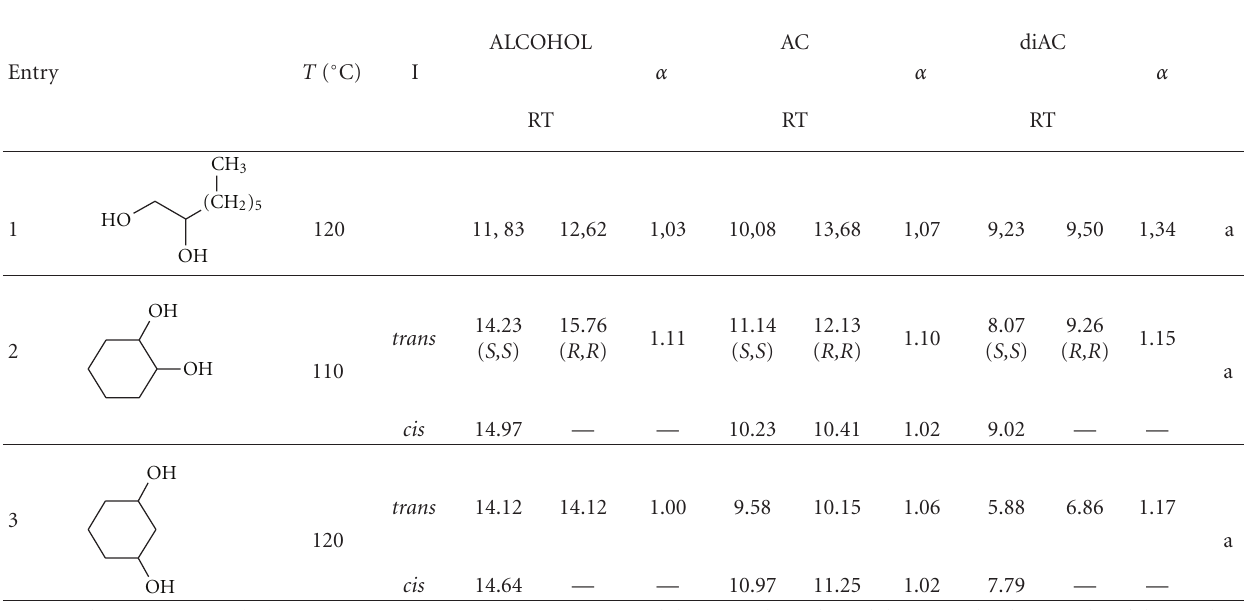
Table 6: Separation factor values ( α ) of the stereoisomers of some diols and their corresponding acetyl derivatives.